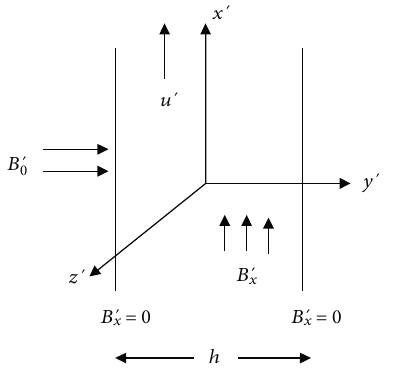
Figure 1: Physical con fi guration and coordinate